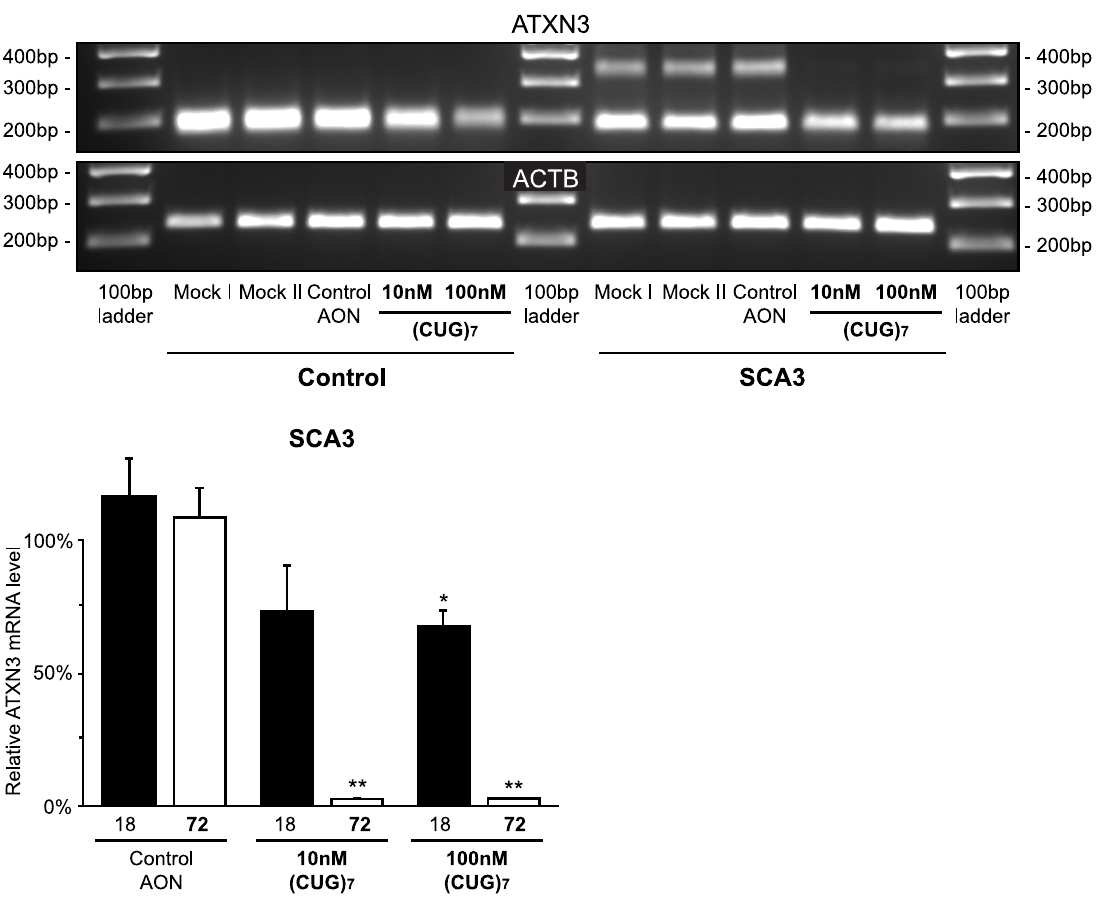
Figure 5. (CUG) 7 AON reduces mutant ATXN3 mRNA expression in patient-derived fibroblasts. Cells were transfected with 10 or 100 nM (CUG) 7 , non-htt specific h40AON2 (Control AON), transfection agent only (Mock II), or non-transfected cells (Mock I). (a) Agarose gel analysis with primers flanking the CAG repeat in the ATXN3 transcript of control (FLB73) and SCA3 (GM06151) fibroblasts after (CUG) 7 treatment. After transfection with (CUG) 7 the upper band, representing the mutant ATXN3 transcript, is greatly decreased in intensity, while the lower band, representing the wild- type transcript, is only slightly reduced. b -actin was used as loading control. (b) Lab-on-a-Chip analysis of ATXN3 transcripts after 10 nM and 100 nM (CUG) 7 treatment in a SCA3 (GM06151) fibroblast cell line. The mutant transcript, with 72 CAGs, is significantly reduced by 97% after (CUG) 7 treatment, compared to transfection controls. The normal ATXN3 transcript with 18 CAGs is reduced by 27% and 33% after 10 nM and 100 nM (CUG) 7 AON treatment, respectively. Expression levels are corrected for loading differences with b -actin. The mRNA level of the Mock I transfection was set on 100% (* P , 0.05, ** P , 0.01,